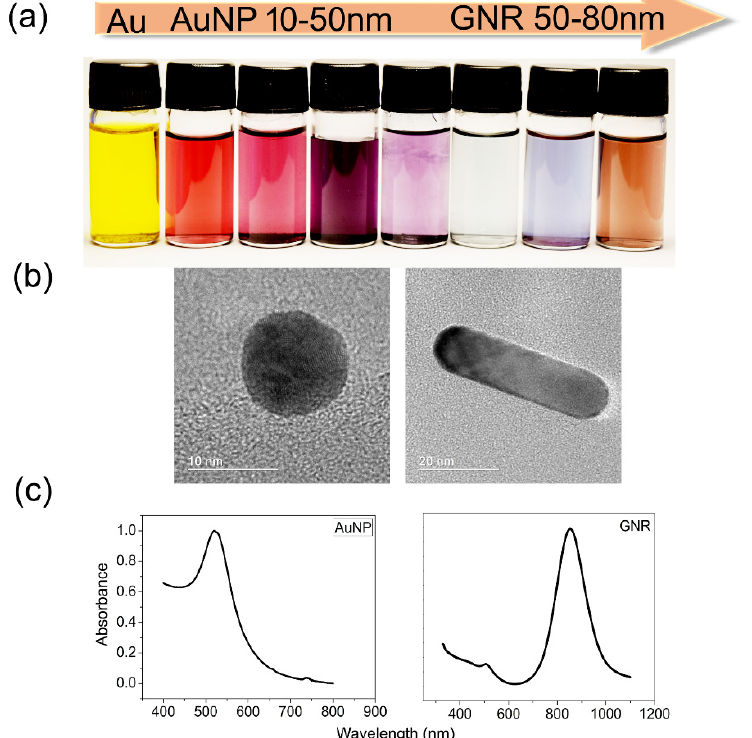
Figure 2. Optical properties of AuNPs. Panel ( a ) shows “colored” nanoparticles due to their inter- action with light. Panel ( b ) shows representative transmission electron microscopy images of an AuNP and a GNR with different shapes and sizes. Panel ( c ) shows the absorption spectra of AuNP at 520 nm and GNR at 850 nm, respectively. Au = gold; AuNP = gold nanoparticle; GNR = gold nanorod. Data were produced in our laboratory.